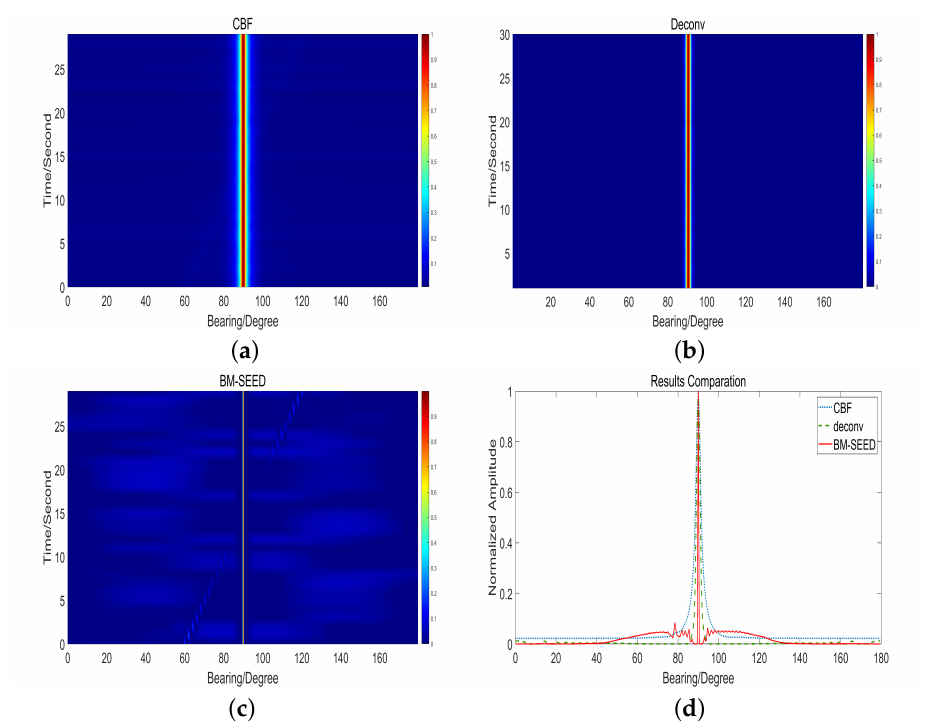
Figure 4. Experiment Results under − 20 dB SIR. ( a ) CBF result under − 20 dB SIR; ( b ) Deconv result under − 20 dB SIR; ( c ) BM-SEED result under − 20 dB SIR; ( d ) Results-Comparison under − 20 dB SIR.